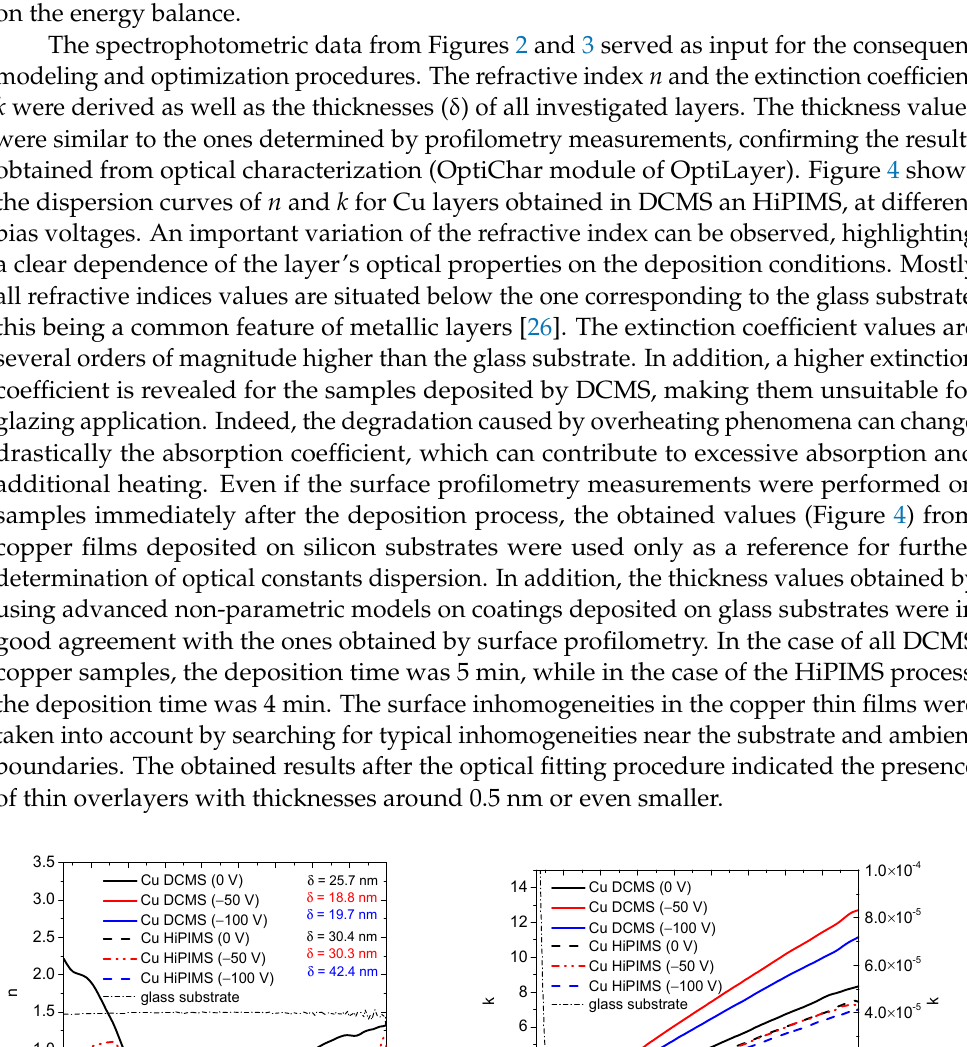
Figure 5. Experimental transmission, reflectance and absorption spectra of copper films obtained immediately after DCMS deposition process (0 h) and after several days exposure to atmospheric pressure conditions. As can be seen, the optical properties are changing from the very first hours after the samples are taken out into the ambient air due to the oxidation phenomena, which occurs at the sample’s surface [12]. If the metal layer is not protected by a dielectric layer, the optical characterization should be performed immediately after transition from vacuum to the atmospheric pressure conditions. In this way, a more accurate evaluation of its optical properties by spectrophotometry measurements is ensured. One should note that